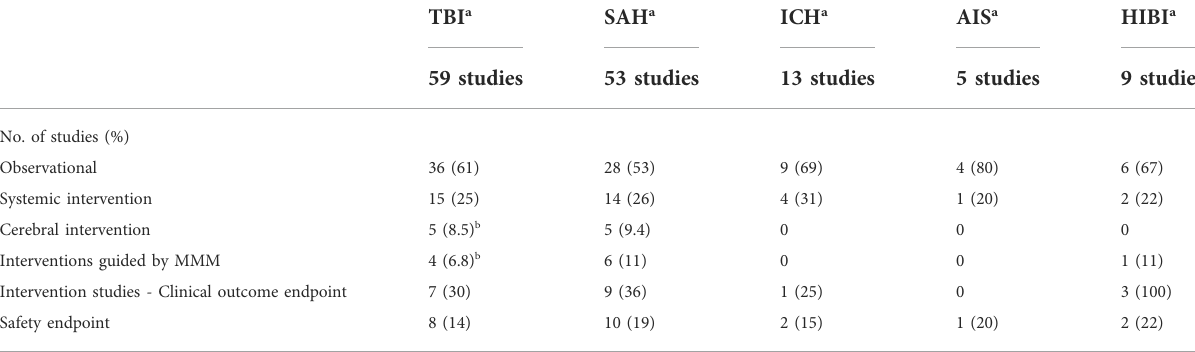
TABLE 3 Study classi fi cation of cerebral multimodality monitoring studies (112